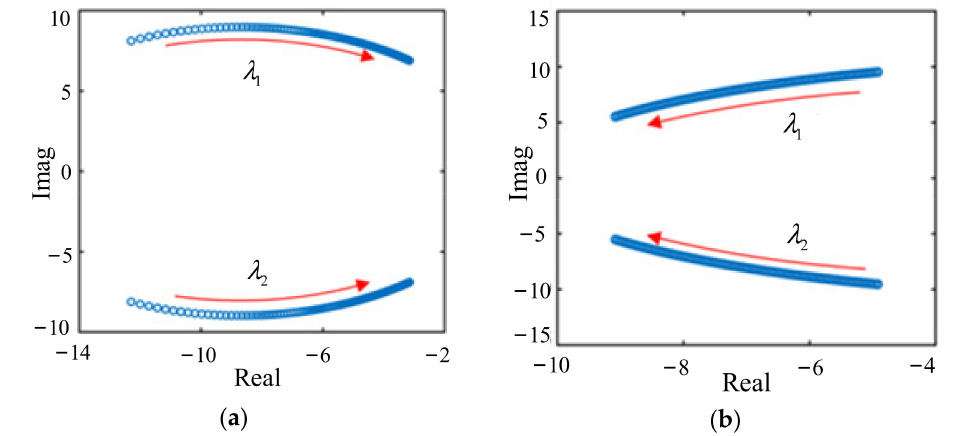
Figure 7. The eigenvalue trajectories under different active power control parameters. ( a ) Eigen-value trajectories of the system under different inertias. ( b ) Eigenvalue trajectories of the system under different damping